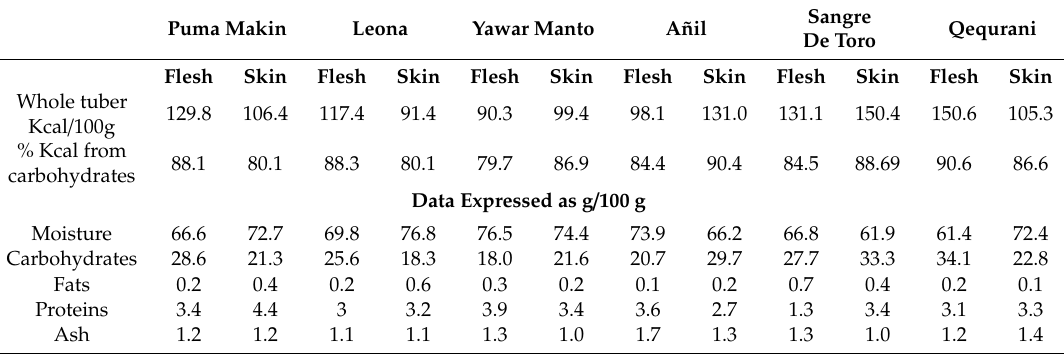
Sangre Qequrani De Toro